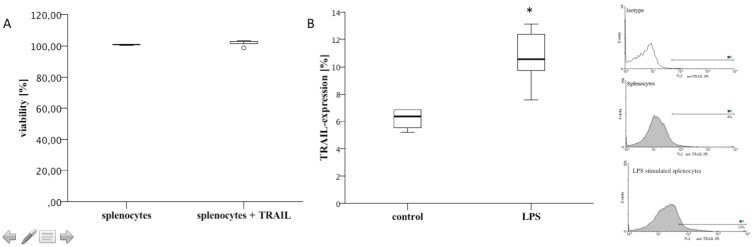
TRAIL-treatment did not influence cell viability in vitro.LPS-stimulation increased TRAIL-expression by splenocytes. A: Cultures of splenocytes were stimulated with TRAIL (100 ng/ml) for 48 hours. Cell viability was determined using a CellTiter Blue Assay. Box plots and outliers are depicted. TRAIL-stimulation did not alter the viability of splenocytes. n = 5/group; results are representative of two independently performed experiments. B: Cultures of splenocytes were stimulated with LPS (1 µg/ml) for 24 hours. TRAIL-expression was determined by FACS analyses. Isotype controls were used for background staining. Box plots and representative histograms of FACS analyses are shown. LPS stimulation significantly increased the expression of TRAIL on the cell surface of splenocytes. One of two experiments in which similar results were obtained is shown. *: p<0.05.